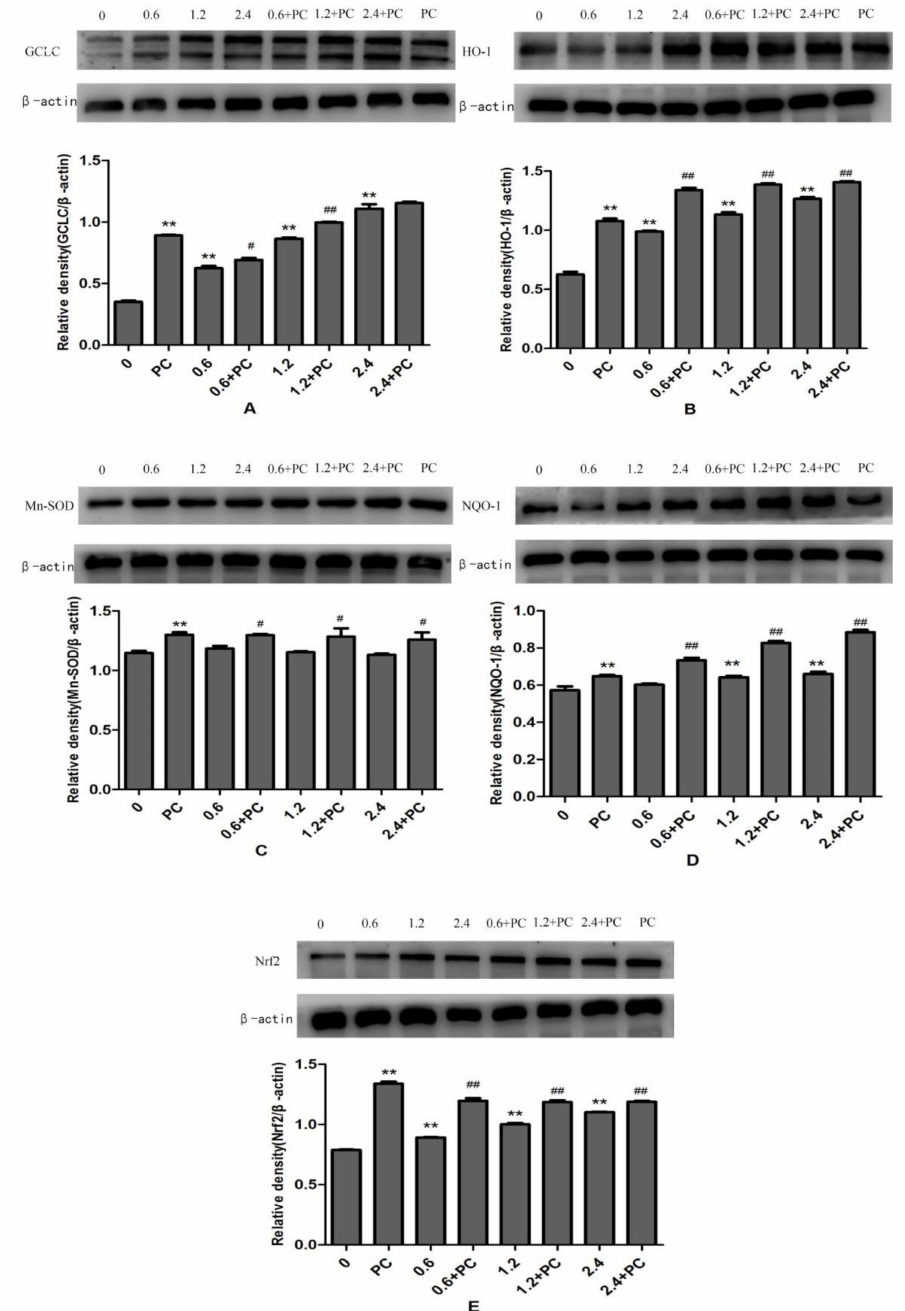
Figure 7. The effect of simultaneous treatment with BHBA and PCs on the protein expression of GCLC, HO-1, Mn-SOD, NQO-1 , and Nrf2 in BEND cells. ** p < 0.01 vs. control group. # p < 0.05 vs. BHBA -treated group, ## p < 0.01 vs. BHBA -treated